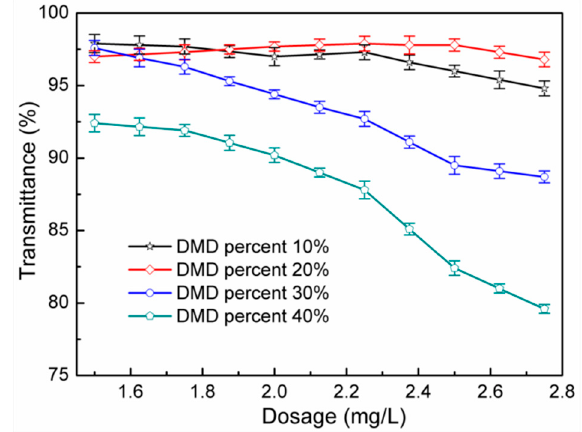
Figure 3. Effect of DMD dosage on transmittance.